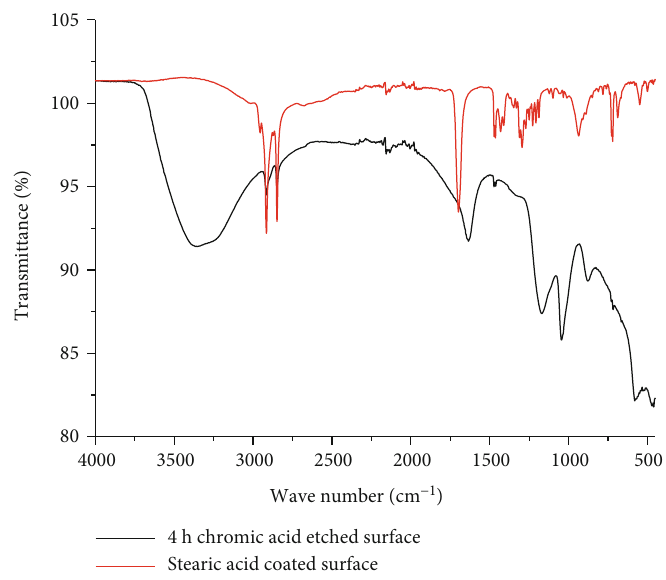
Figure 12: FTIR spectrum of composite material before and after surface modi fi cation.